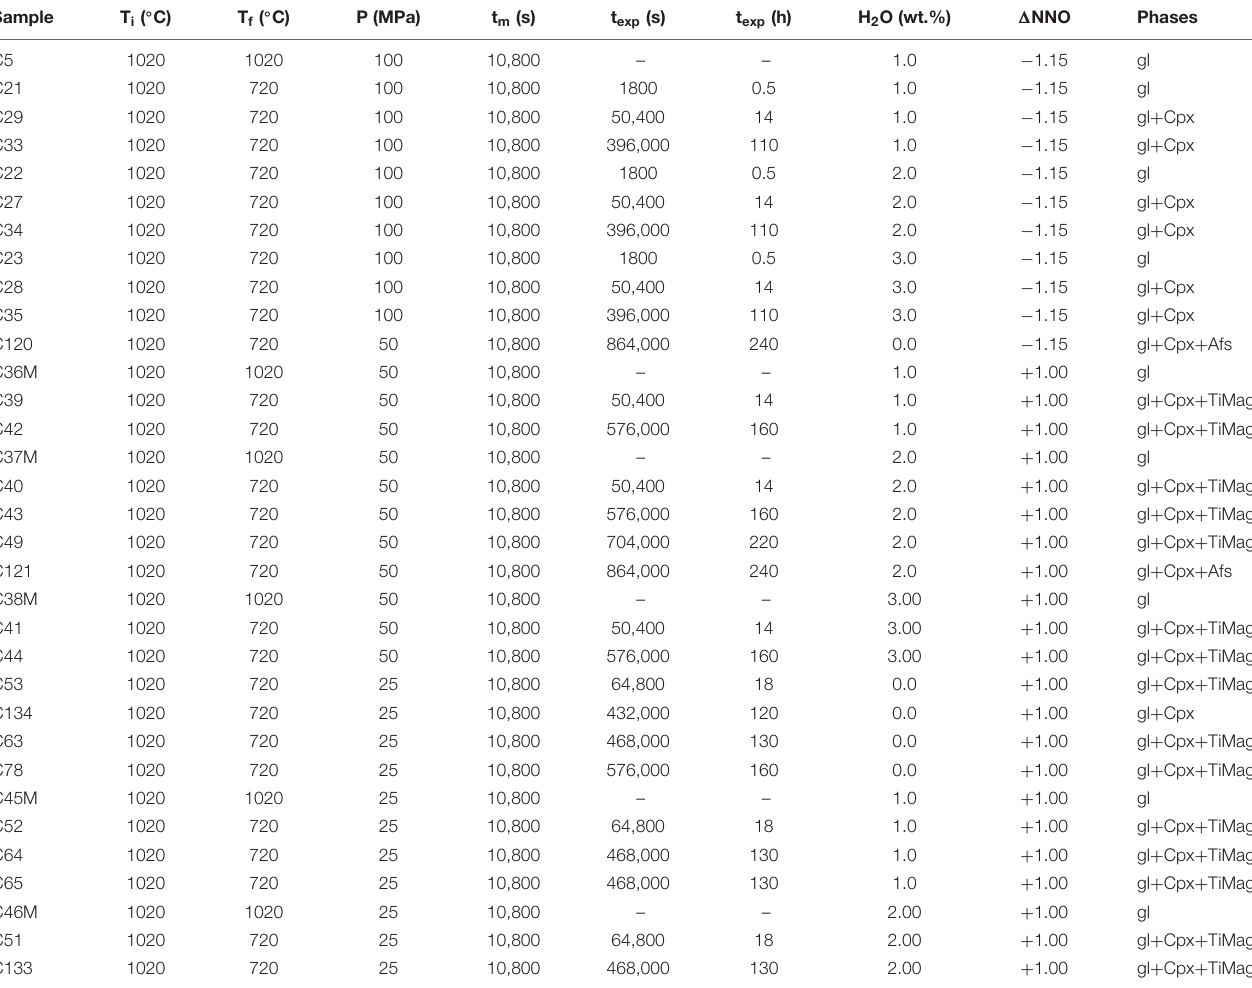
TABLE 3 | Experimental condition of water-undersaturated